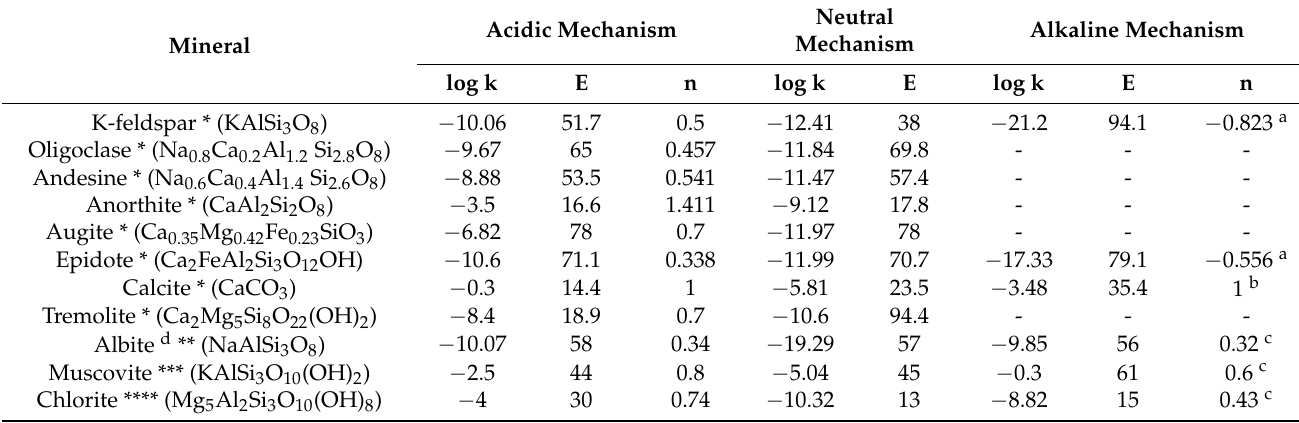
Table 1. List of dissolution rate parameters used in this study to kinetically simulate the neutralization potential under a wide range of pH. Neutral Acidic Mechanism Mineral